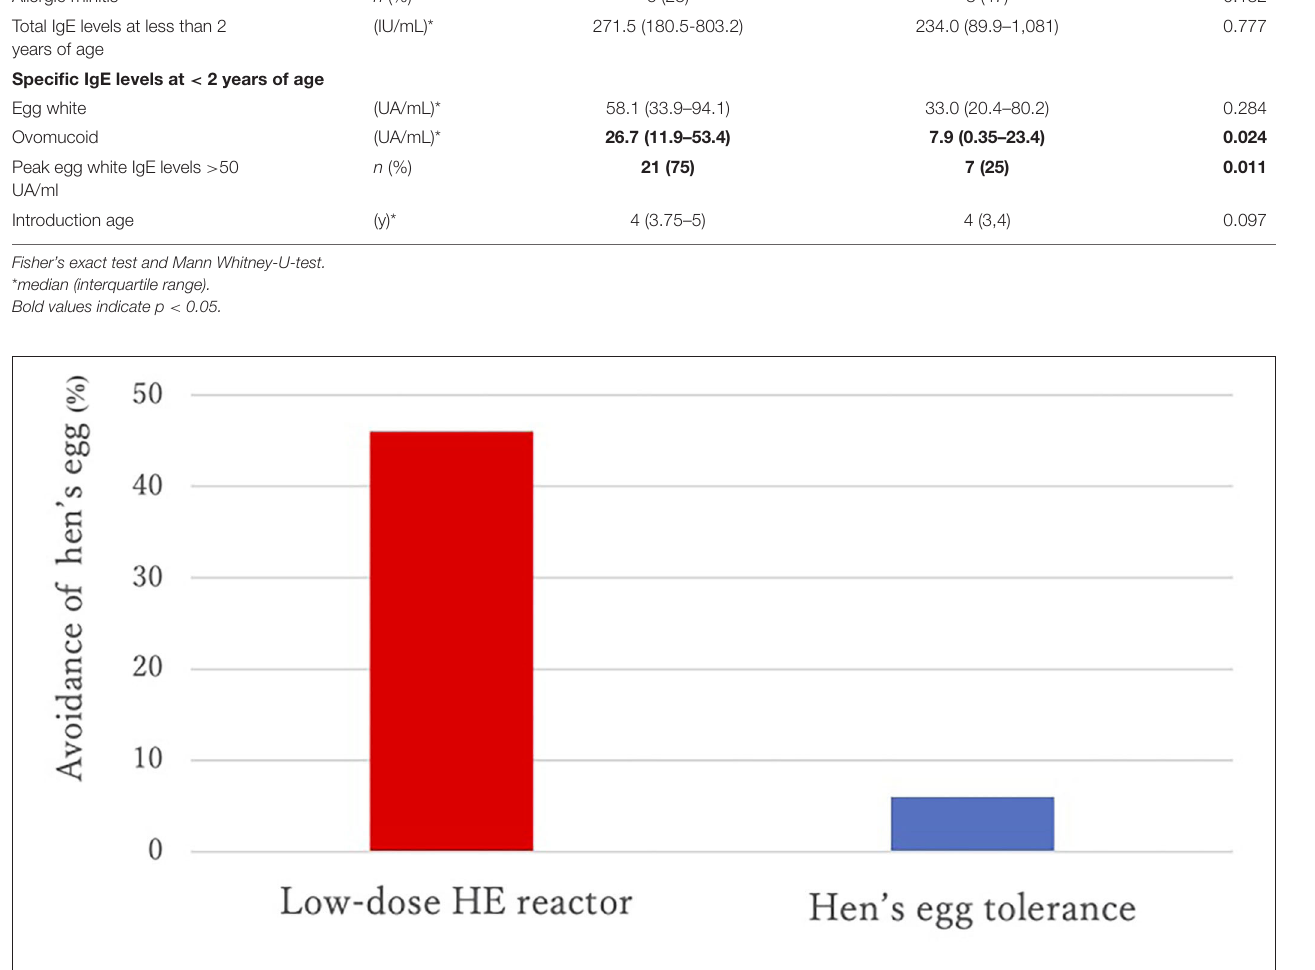
FIGURE 2 | Avoidance of hen’s egg of the two